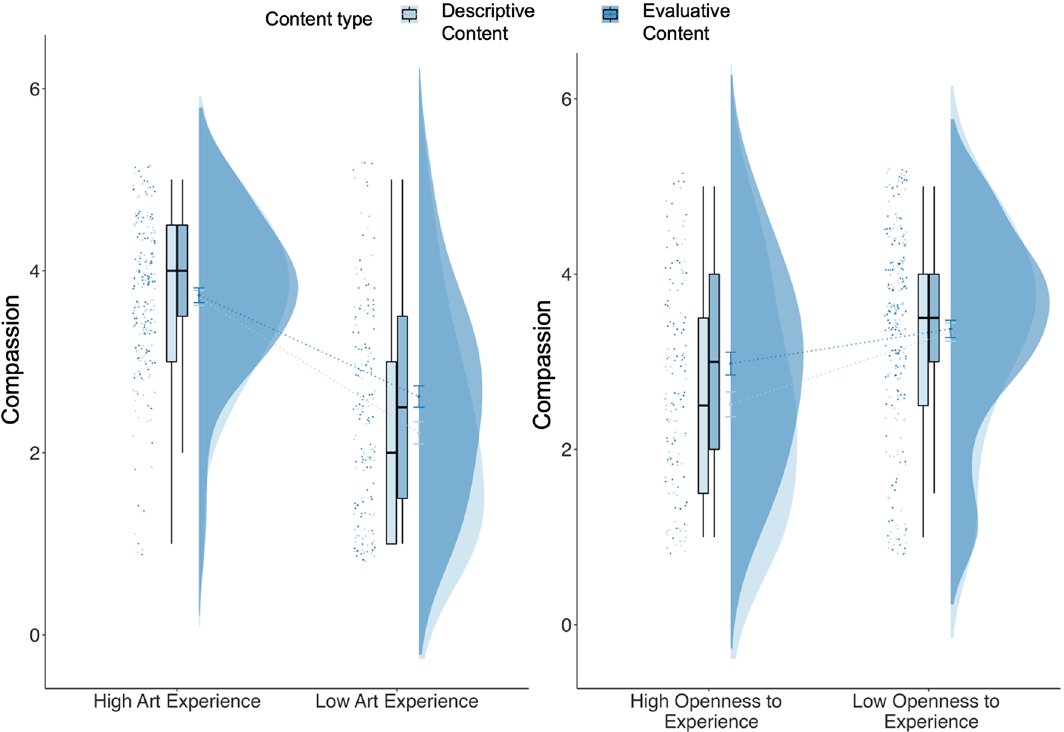
Figure 9. Difference in ratings of how much compassion participants felt when provided with descriptive and elaborative content information, split by participants with low and high art experience, and low and high openness to